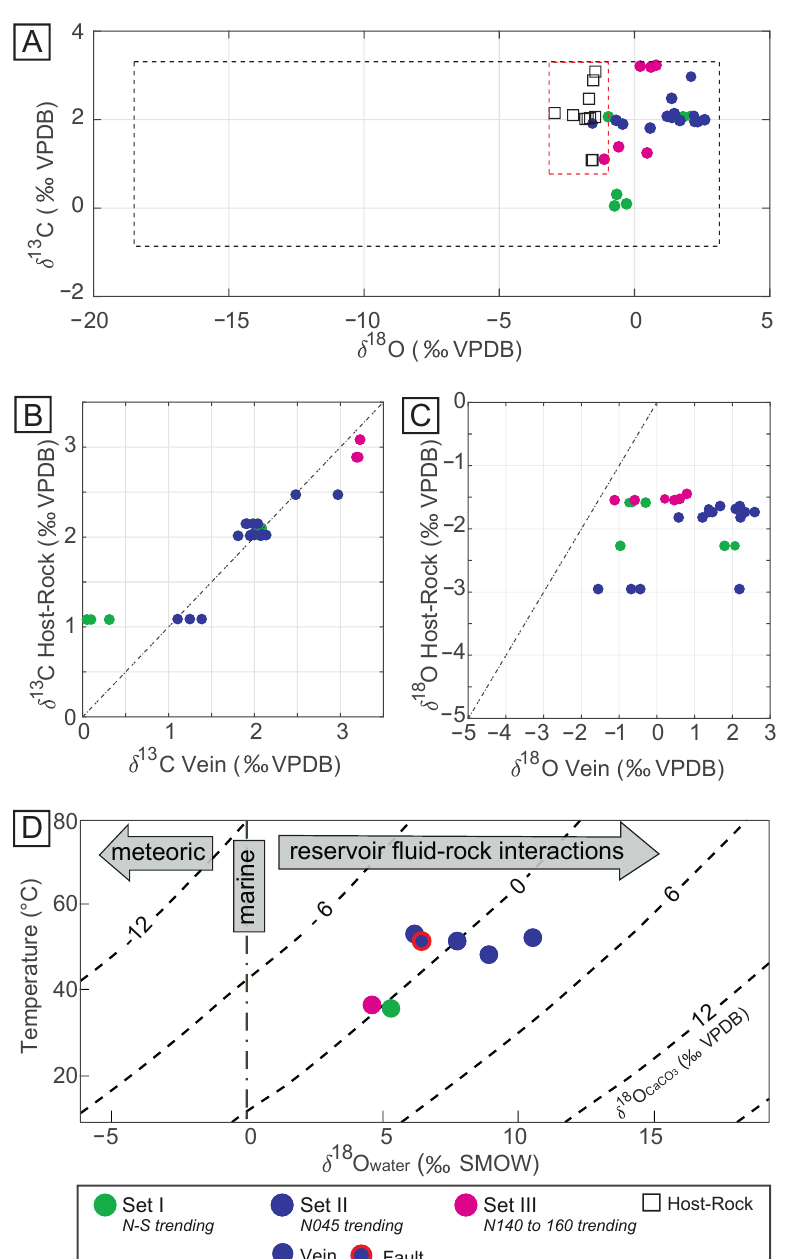
Figure 7. Isotopic data from tectonic veins, faults and host-rocks sampled in the Scaglia Rossa. ( A ) Oxygen versus Carbon stable isotopic ratio (‰VPDB) of host rocks (black squares), and vein cements according to the vein sets. Red dotted frame represents the range of isotopic values doc- umented in the UMAR from the Hettangian to Aquitanian carbonates, black dotted frame repre- sents the range of isotopic values documented in tectonic related fracture fillings at the scale of the range [60]. ( B ) δ 13 C values of vein cements versus δ 13 C values of the surrounding host rocks (‰VPDB), according to the vein sets. ( C ) δ 18 O values of vein cements versus δ 18 O values of the surrounding host rocks (‰VPDB), according to the vein sets. ( D ) ∆ 47 CO 2 measured temperature of precipitation ( ◦ C) versus δ 18 O values of calcite cements (‰VPDB, oblique dotted lines) and cor- responding δ 18 O values of the related fluids (‰SMOW) calculated from temperature-dependent fractionation equation CaCO 3 -H 2 O of [141]. For A-D, tectonic veins are reported as full circles of which color relates to the set they belong to (green: N-S, blue: N045, purple: N140). Note that the circle with red contour on D correspond to an LPS-related